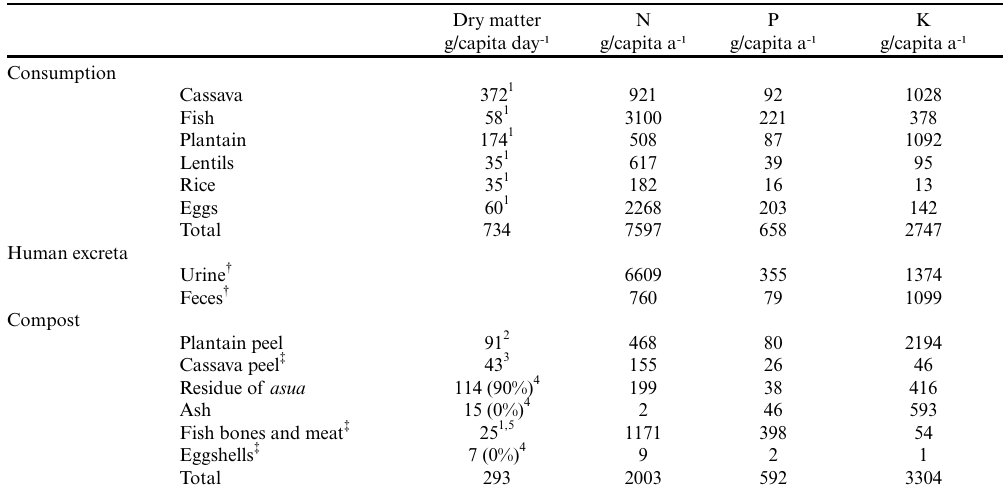
Table 2 . Household nutrient fluxes and the amount of food consumption, human excreta, and household waste. Own analysis was complemented by literature, indicated by the superscripts below.